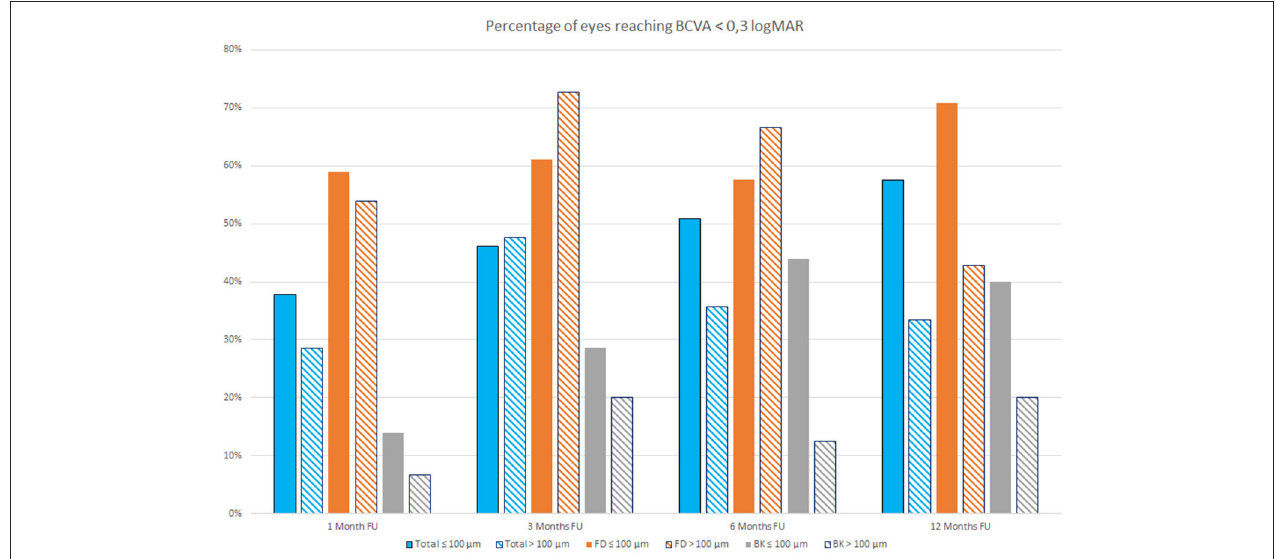
FIGURE 2 | Percentage of eyes reaching Best Correct Visual Acuity (BCVA) < 0.3 LogMAR at 1, 3, 6, and 12 months follow-up (FU) that received a lenticule thinner (full colored bars) or thicker than 100 µ m (stripes colored bars) both in the overall study population (blue bars) and in Fuchs dystrophy (FD) eyes (orange bars) and in bullous keratopathy (BK) eyes (gray bars).